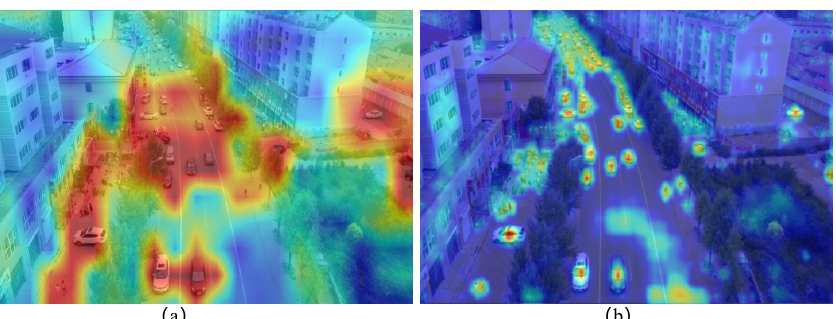
Figure 2. The heatmap visualization of the high-level ( a ) and low-level ( b ) features. The features visualized in ( a ) appear to be noisy, covering more background but missing the small targets (the cars) in the far distance region. The features visualized in ( b ) focus more accurately on the objects, especially on small